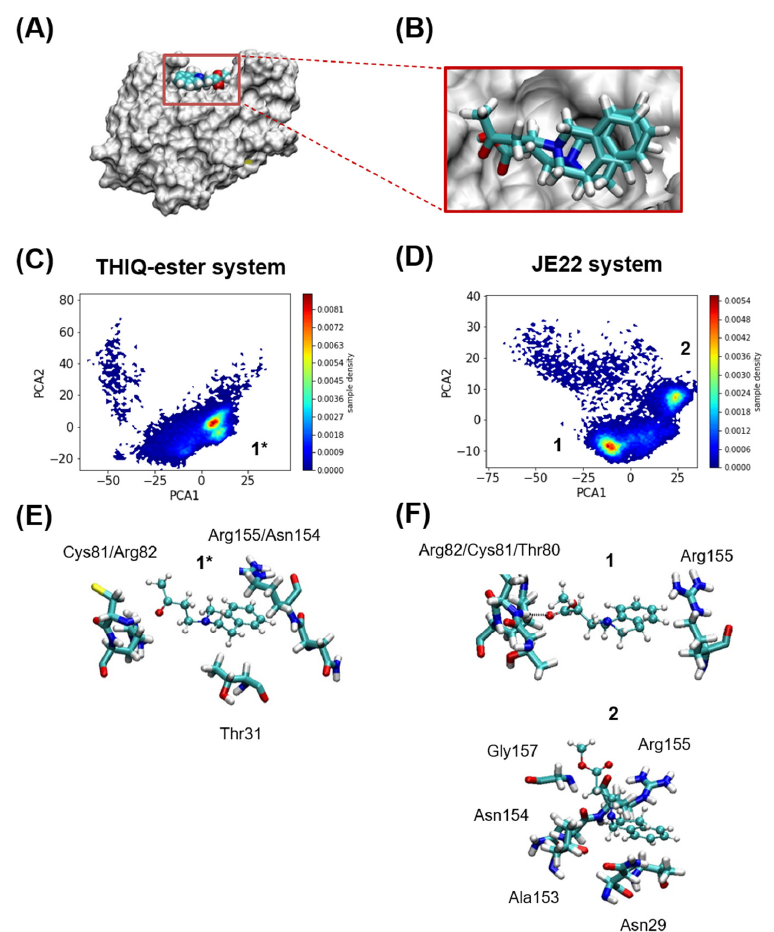
Figure 2. Computational analysis. ( A ) Murine CD44 HABD in MSMS representation in white, and THIQ-Ester in VDW representation at the position where it is found in the crystal structure PDB id 5BZK, used as starting point of the MD simulations. ( B ) Relative positions of JE22 and THIQ-ester ligands at the start of the MD simulations. The JE22 molecule was aligned using the position of the THIQ-ester ligand in the crystal structure PDB id 5BZK. ( C , D ) Comparison of MD-resolved